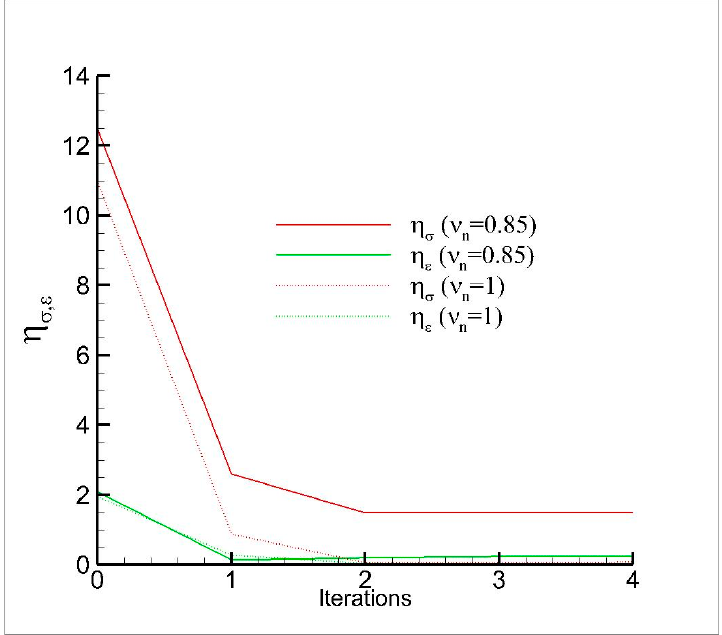
Figure 17. Global/Local performance with respect to the Reference Model—conformal mesh and Figure 17. Global / Local performance with respect to the Reference Model—conformal mesh and optimal non–conformal mesh—Local Model 3. optimal non–conformal mesh—Local Model